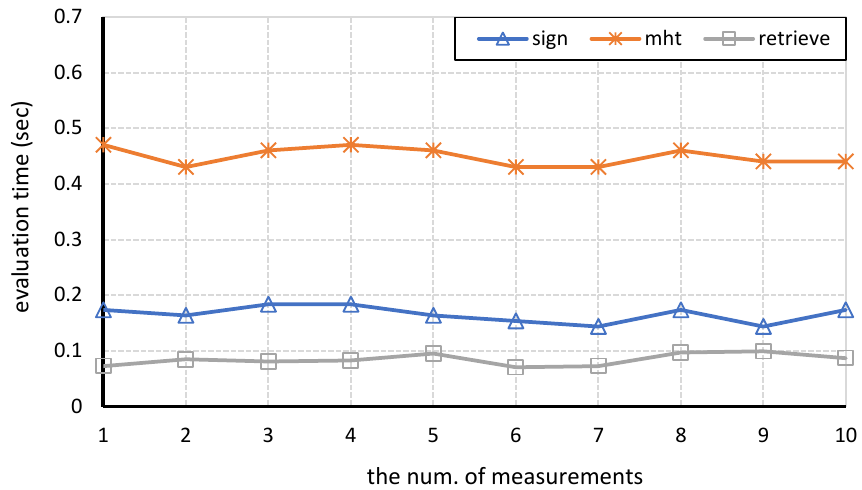
Figure 3. The performance evaluation of data authentication schemes.